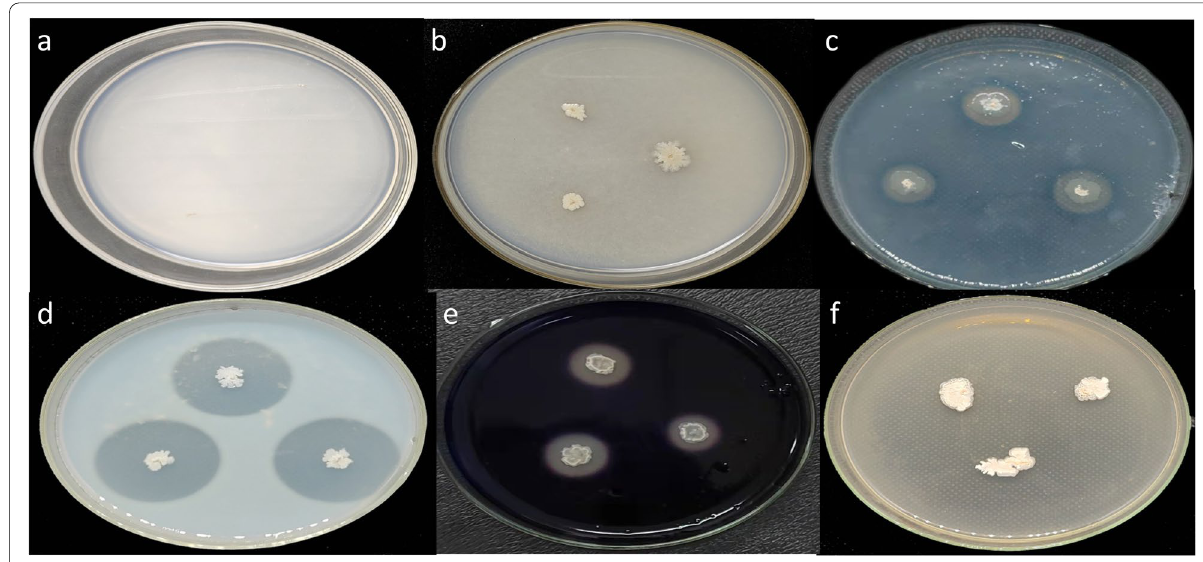
Fig. 4 Evaluation of strain K-9 for key traits related to direct plant growth promotion. a Nitrogen fixation. b organophosphorus qualitative assay. c Iron qualitative assay. d Protease qualitative assay. e Amylase qualitative activity assay. f ACC deaminase activity